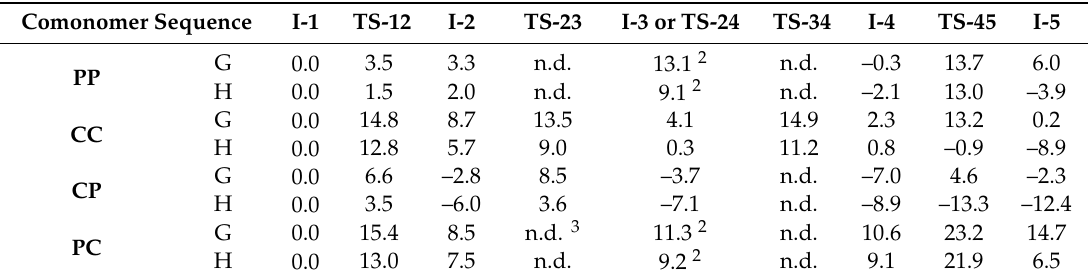
Table 1. Calculated free energies and free enthalpies (kcal / mol) of stationary points and transition states for di ff erent comonomer sequences in ε -CL / methyl ethylene phosphate (MeOEP) copolymerization. 1. Comonomer Sequence